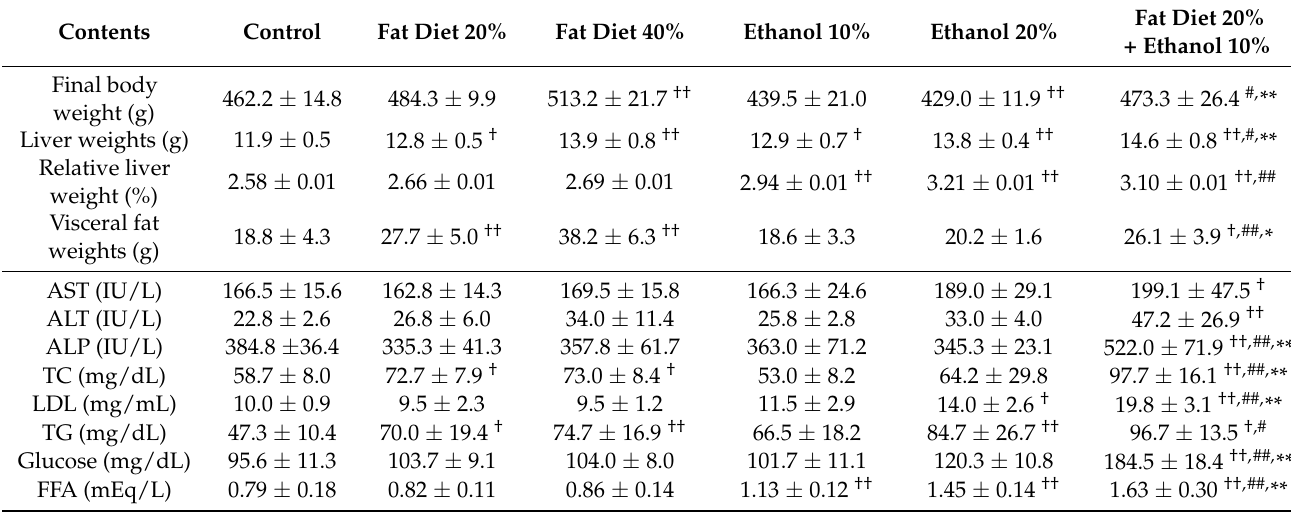
Table 1. Changes of body, organ mass and serum